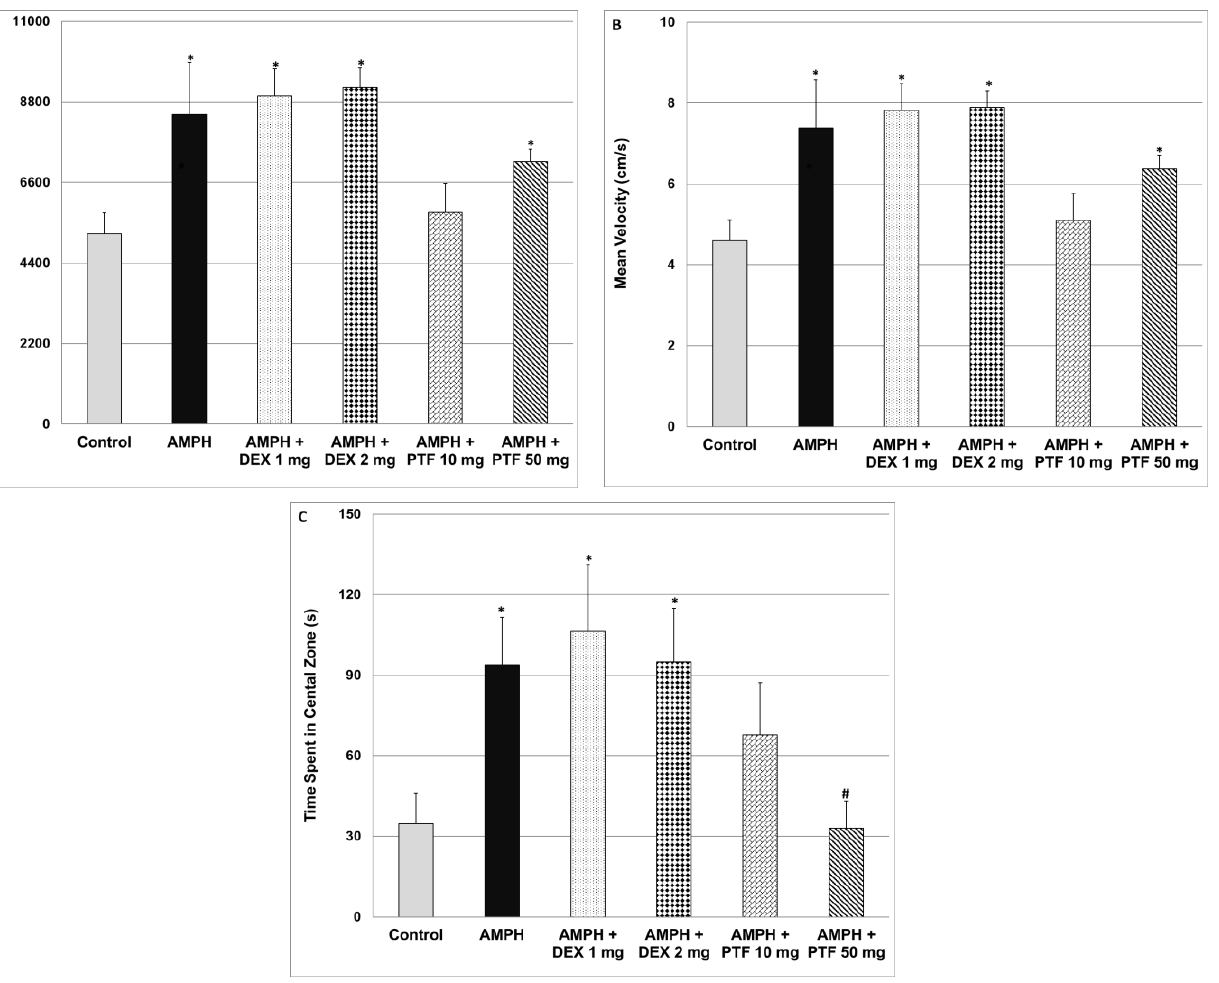
Figure 2. Effects of DEX and PTF on amphetamine-induced hyperactivity and risk-taking behavior. Values are mean ± SEM of 10 – 12 rats in each group. ( A ) One-way ANOVA test: F = 8.57, p < 0.0001; t -test: * p < 0.05 vs. control. ( B ) One-way ANOVA test: F = 8.05, p < 0.0001; t -test (two-tailed): * p < 0.05 vs. control. ( C ) One-way ANOVA test: F = 2.99, p = 0.0173; t -test (two-tailed): * p < 0.05 vs. control, # p < 0.05 vs. amphetamine. AMPH — amphetamine, DEX — dexamethasone, PTF — pentoxi- fylline.